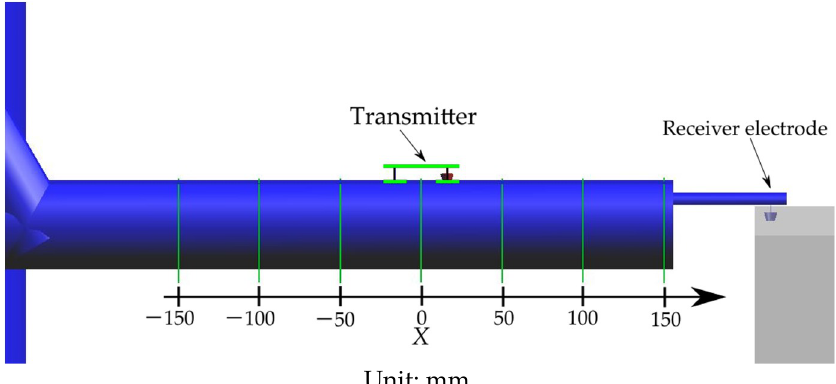
Figure 7. Locations of cross-sections along the arm model.